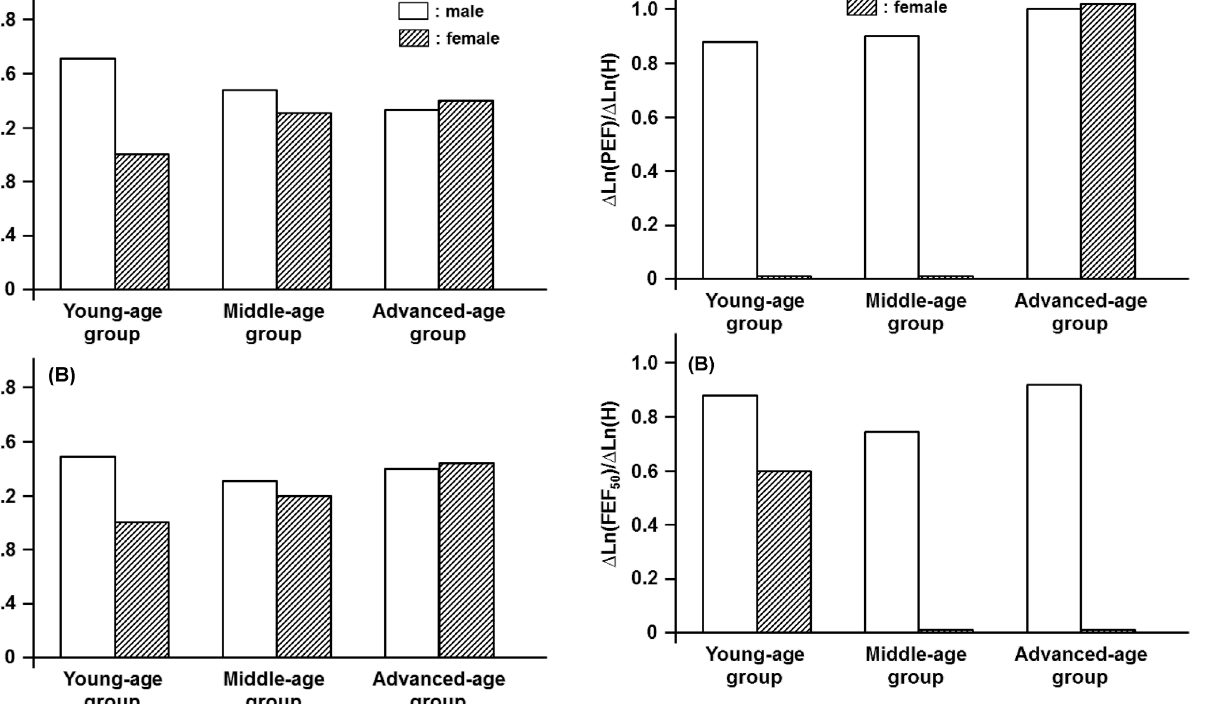
Figure 1. Age-specific effects of height (H) on decision of FVC and FEV 1 estimated for three different age groups of either males or females. (A): Partial regression coefficients of Ln(H) for reference means of Ln(FVC) in young-, middle-, and advanced-age groups of both genders. Partial regression coefficients of Ln(H) for Ln(FVC) are denoted as D Ln(FVC)/ D Ln(H). (B): Partial regression coefficients of Ln(H) for Ln(FEV 1 ) are designated as D Ln(FEV 1 )/ D Ln(H).